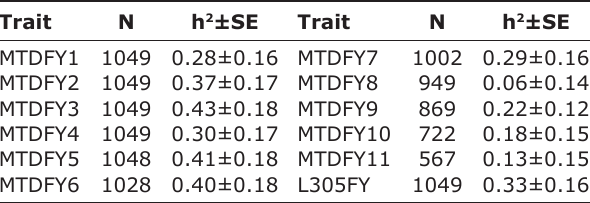
Table-3: Heritability estimates along with their standard error for L305FY and different MTDFY. Trait N h 2